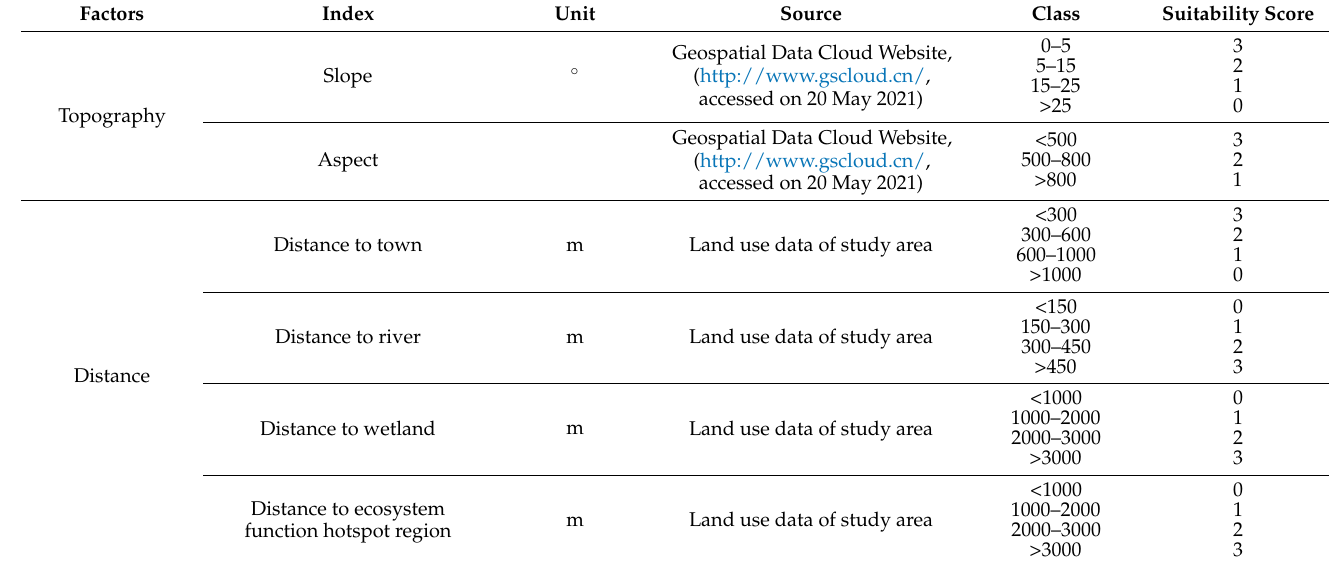
Table 5. Suitability evaluation factors and scores of construction land in the study.